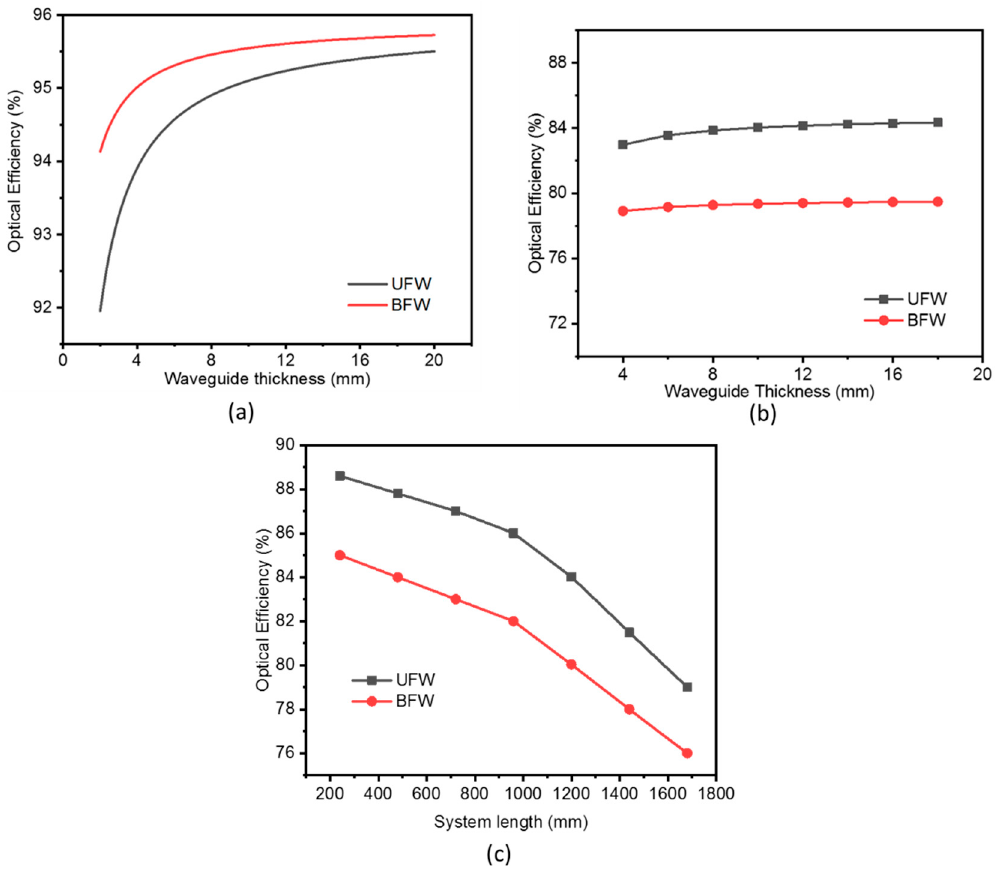
Figure 9. The dependence of optical efficiency on the waveguide thickness: ( a ) theoretical analysis for case of coupling angle ( ϕ ) = 30 ° and ( b ) simulation results. ( c ) Simulation result for the optical efficiency depends on system length.